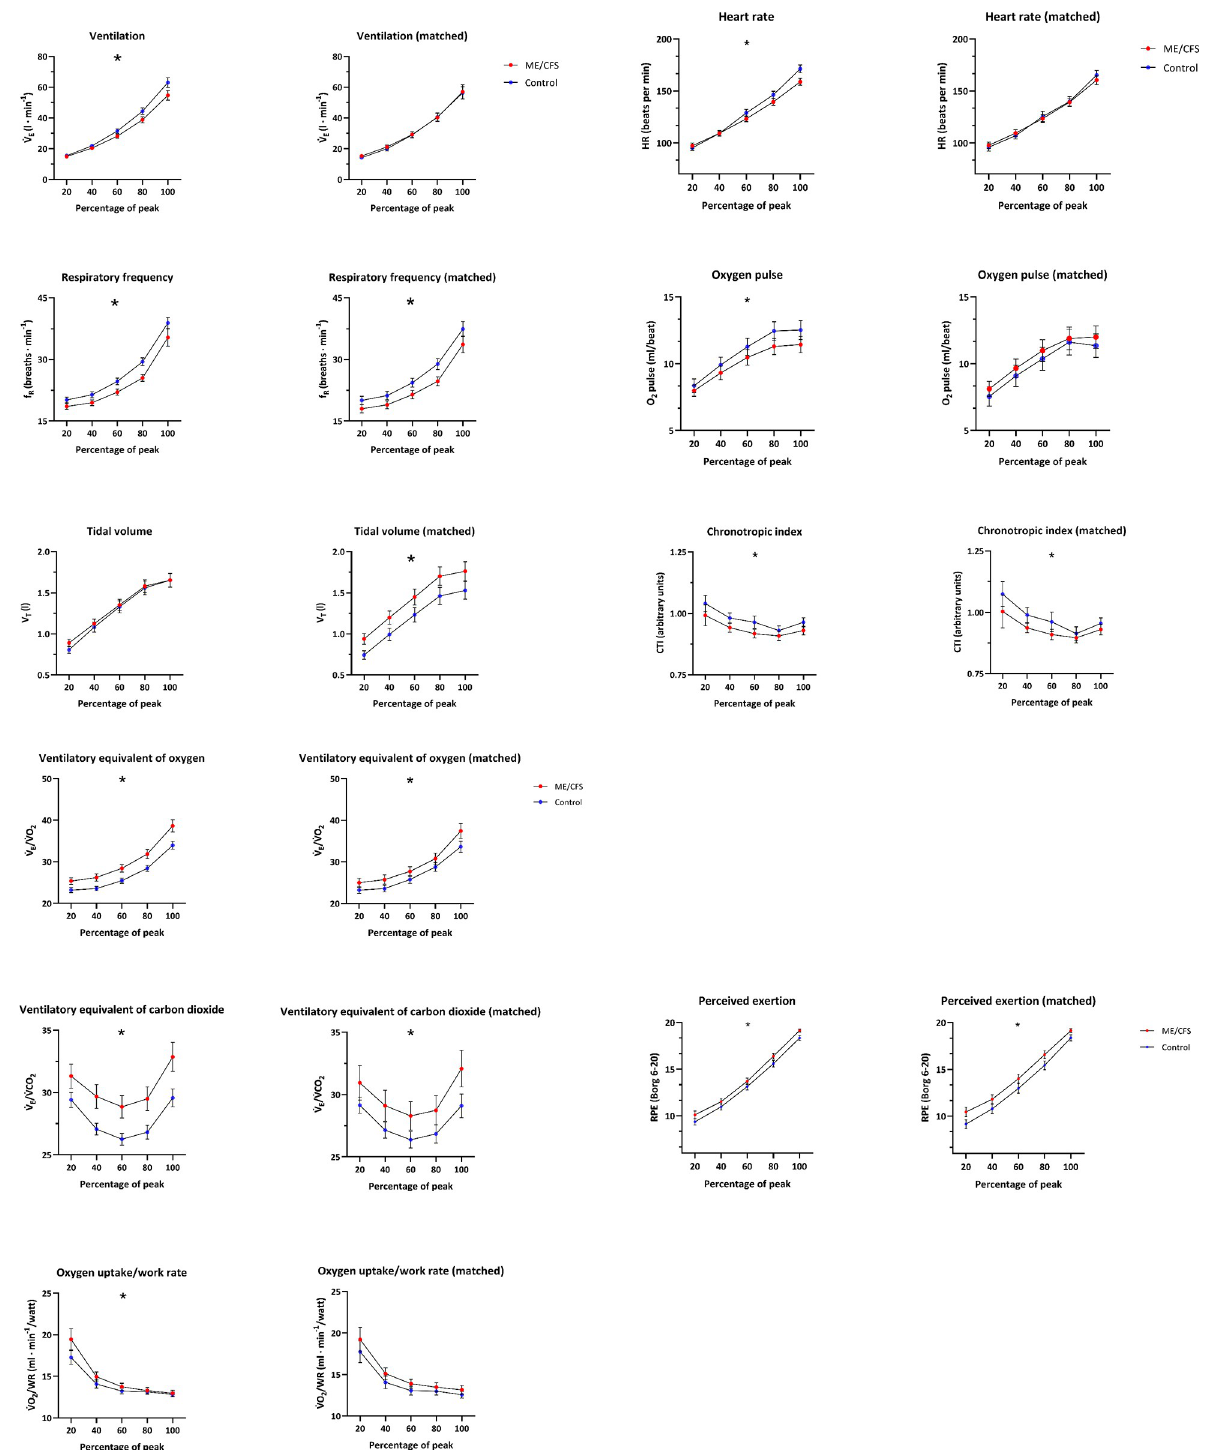
Fig 1. Mean (95% CI) cardiopulmonary exercise testing values for participants with ME/CFS and otherwise healthy controls. Plots in the left column show values for the full study sample (ME/CFS = 178; Controls = 169) and plots in the right column show values for the fitness-matched subgroup (ME/CFS = 99; Controls = 99). Data are expressed as 20, 40, 60, 80, and 100% of peak oxygen uptake. Significant findings from the linear mixed effects models of the entire exercise response are denoted with � . a. Ventilatory parameters—ventilation ( _ VE ), respiratory frequency ( f R ), and tidal volume (V T ). b. Heart rate parameters—heart rate (HR), oxygen pulse ( _ VO = HR ), and chronotropic index (CTI). c. Efficiency related 2